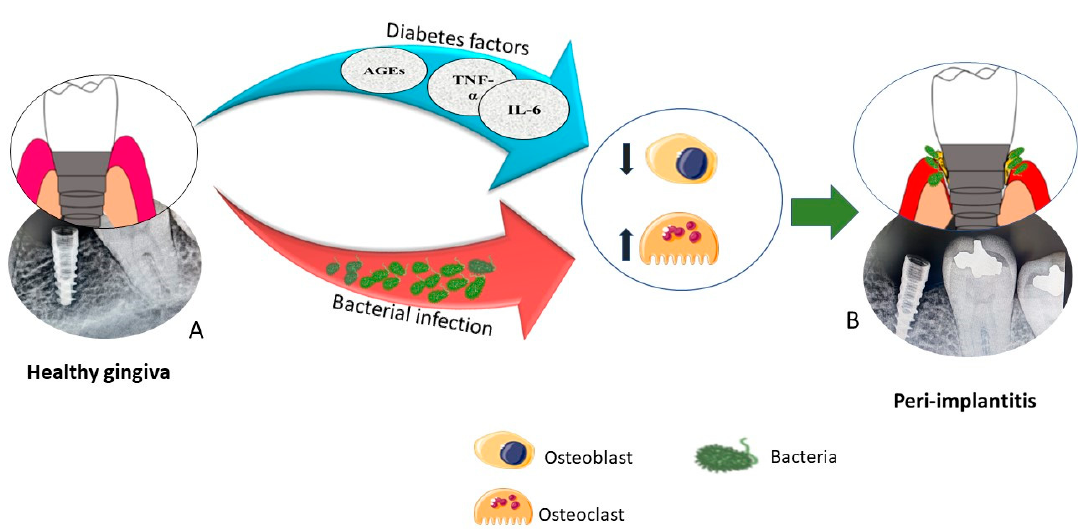
Figure 1. Effect of diabetes mellitus on dental implant failure. ( A ) Illustration and a representative intra oral periapical image (IOPA) of a diabetic patient who had received implant placement. This was taken immediately after the surgical placement of a dental implant. ( B ) Illustration and a follow up IOPA showing the failure of the dental implant due to infection. Image courtesy of Dr. Bijoy John, Indira Gandhi Institute of Dental Science, Kerala, India.